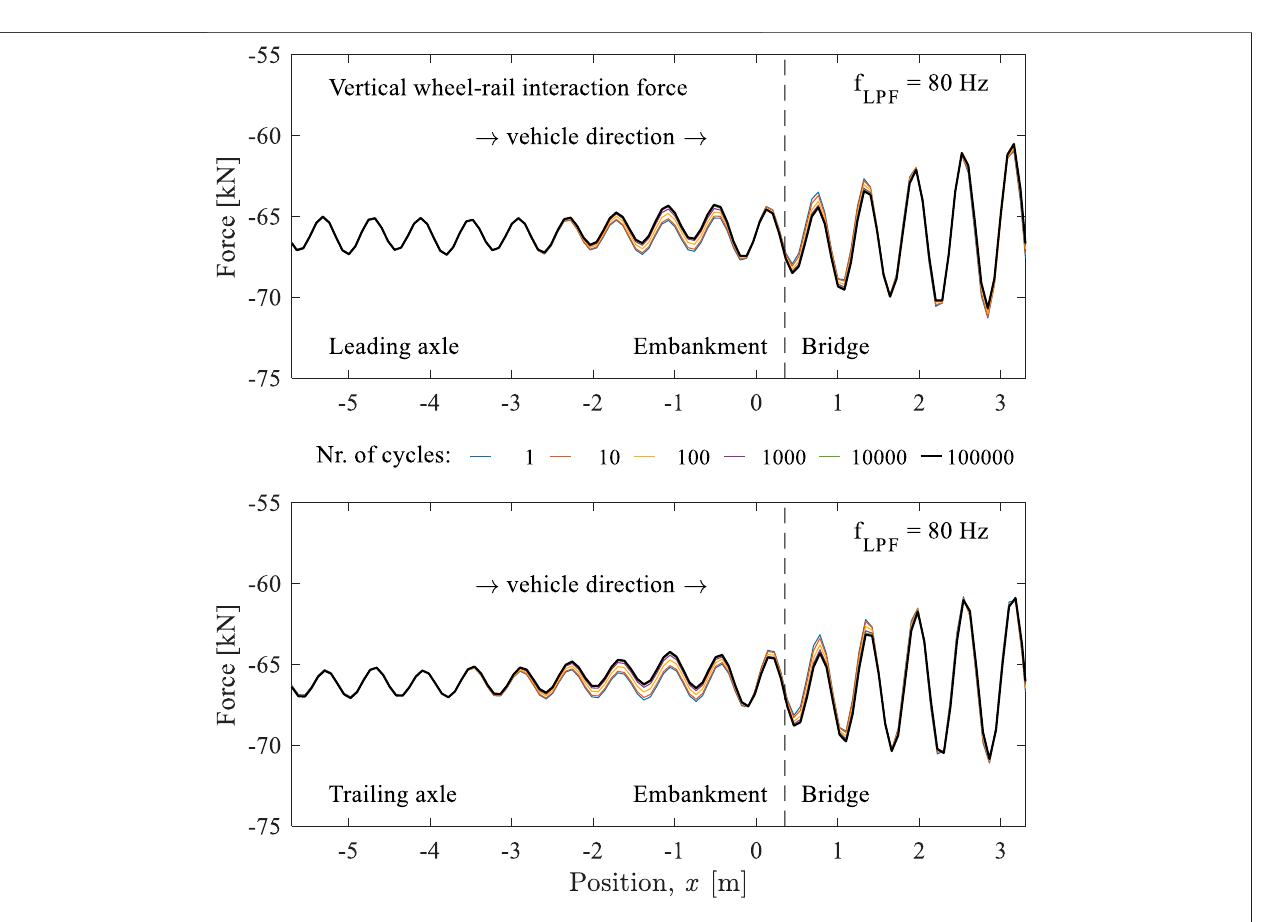
Frontiers in Built Environment |